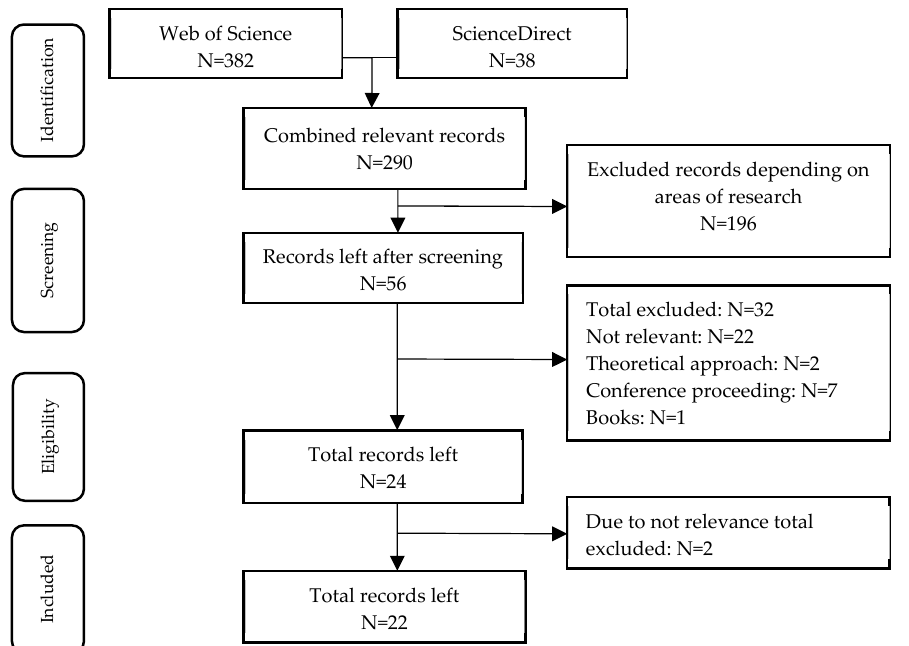
Figure 1. PRISMA methodology scheme .